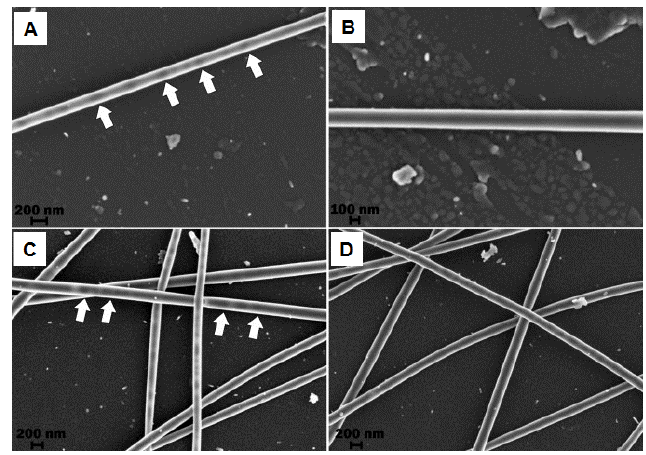
Figure 6. SEM micrographs of PVA/(graphene foam and expanded graphite) NFs at 2 kV operating voltage for ( A ) solution with 0.02 g GF concentration, ( B ) solution with 0.08 g GF concentration, ( C ) solution with 0.02 g EG concentration and ( D ) solution with 0.08 g EG. Reprinted with permission from reference [77]. Copyright Elsevier, 2015.